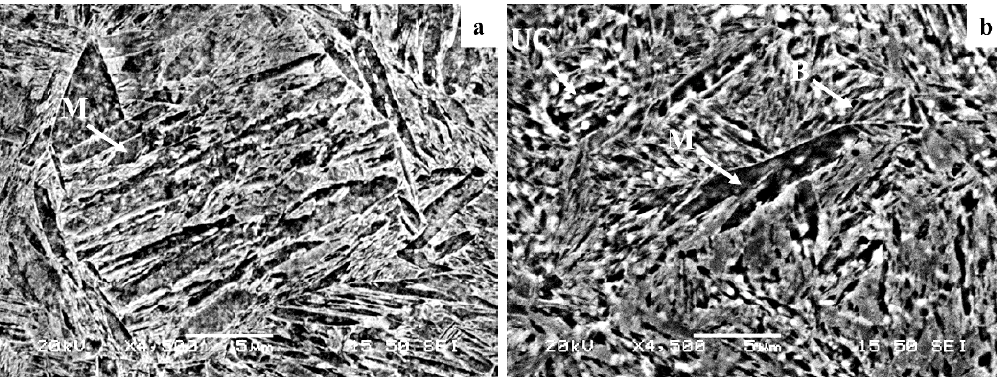
Figure 3. SEM images of the CH ( a ) and the UFH sample ( b ). The CH consists of a martensitic (M) matrix while the UFH sample consists of a martensitic (M) matrix with undissolved cementite (UC) and bainite (B).